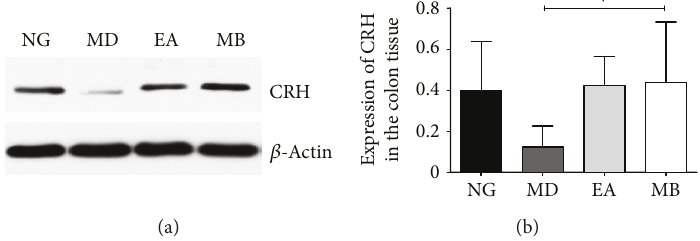
Figure 6: The protein expressions of CRH in the distal colon tissue. (a) The protein expression of CRH in the colon was evaluated by Western blot analysis. (b) Quanti fi cation of (a) ( n = 12 ). The results showed that the intestinal CRH expression in the MD group was reduced (vs. NG group, P > 0 05 ), while it signi fi cantly enhanced by EA and MB treatment (vs. MD group). In addition, there was an obvious di ff erence between the MD and the MB groups ( ∗ P < 0 05 ). CRH: corticotropin-releasing hormone. NG: normal group; MD: model group; EA: electroacupuncture group; MB: moxibustion